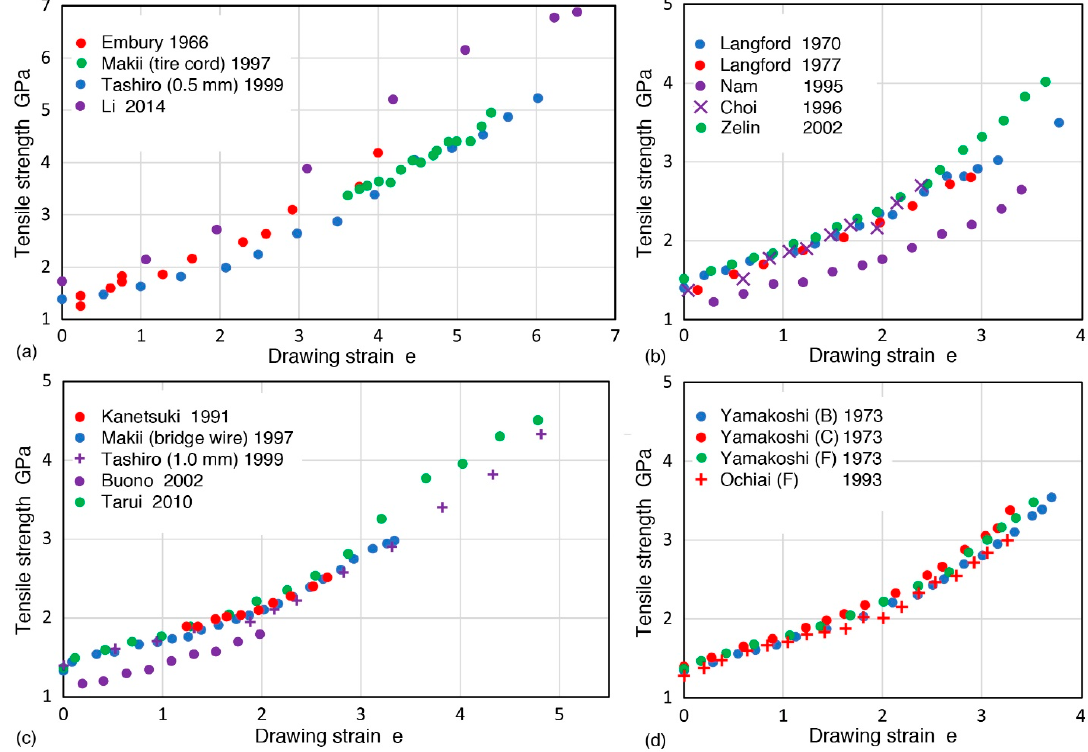
Figure 2. Tensile strength, σ ts versus drawing strain, e , for 18 data sets. ( a ) Data from [3,30,36,48]. ( b ) Data from [31,32,38,41,42]. ( c ) Data from [36,37,46,48,49]. ( d ) Data from [15,47]. See inserts for symbols used.